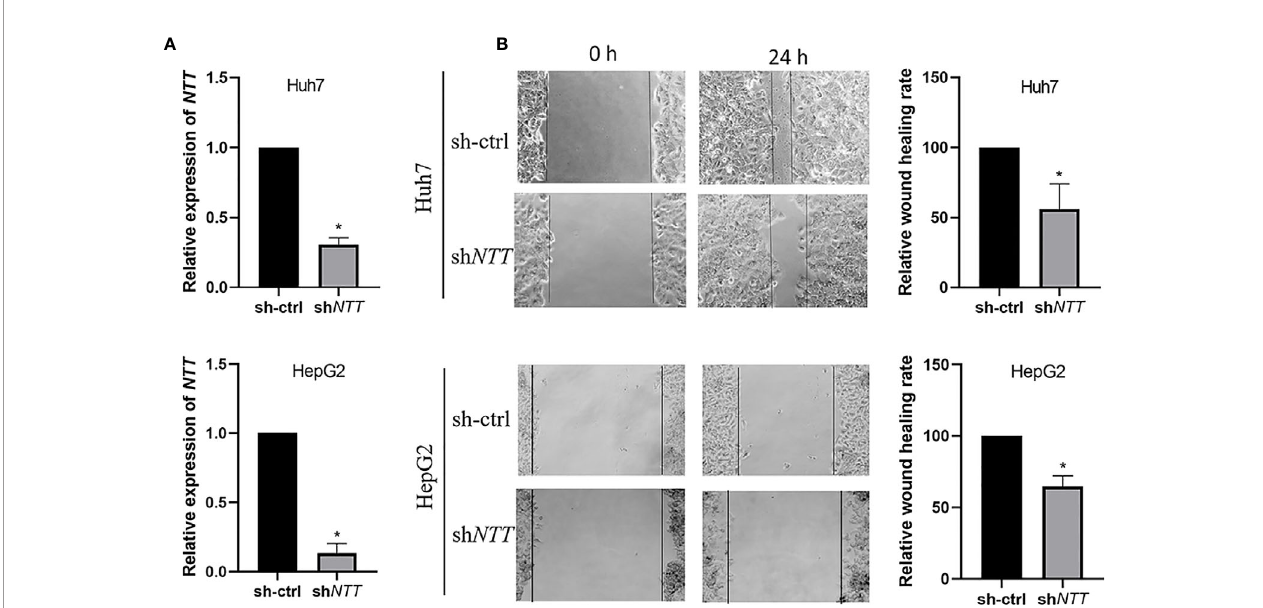
FIGURE 3 | NTT knockdown reduced cell migration ability. (A) Expression of NTT was determined by qPCR. (B) Knockdown of NTT inhibited cell migration. Data are shown as the mean ± standard deviation (n = 3). * p < 0.05 for sh-ctrl vs. sh NTT